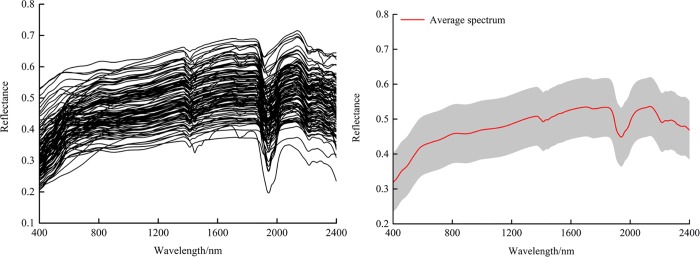
Average reflectance spectra curves and their corresponding standard deviation values (shaded regions).